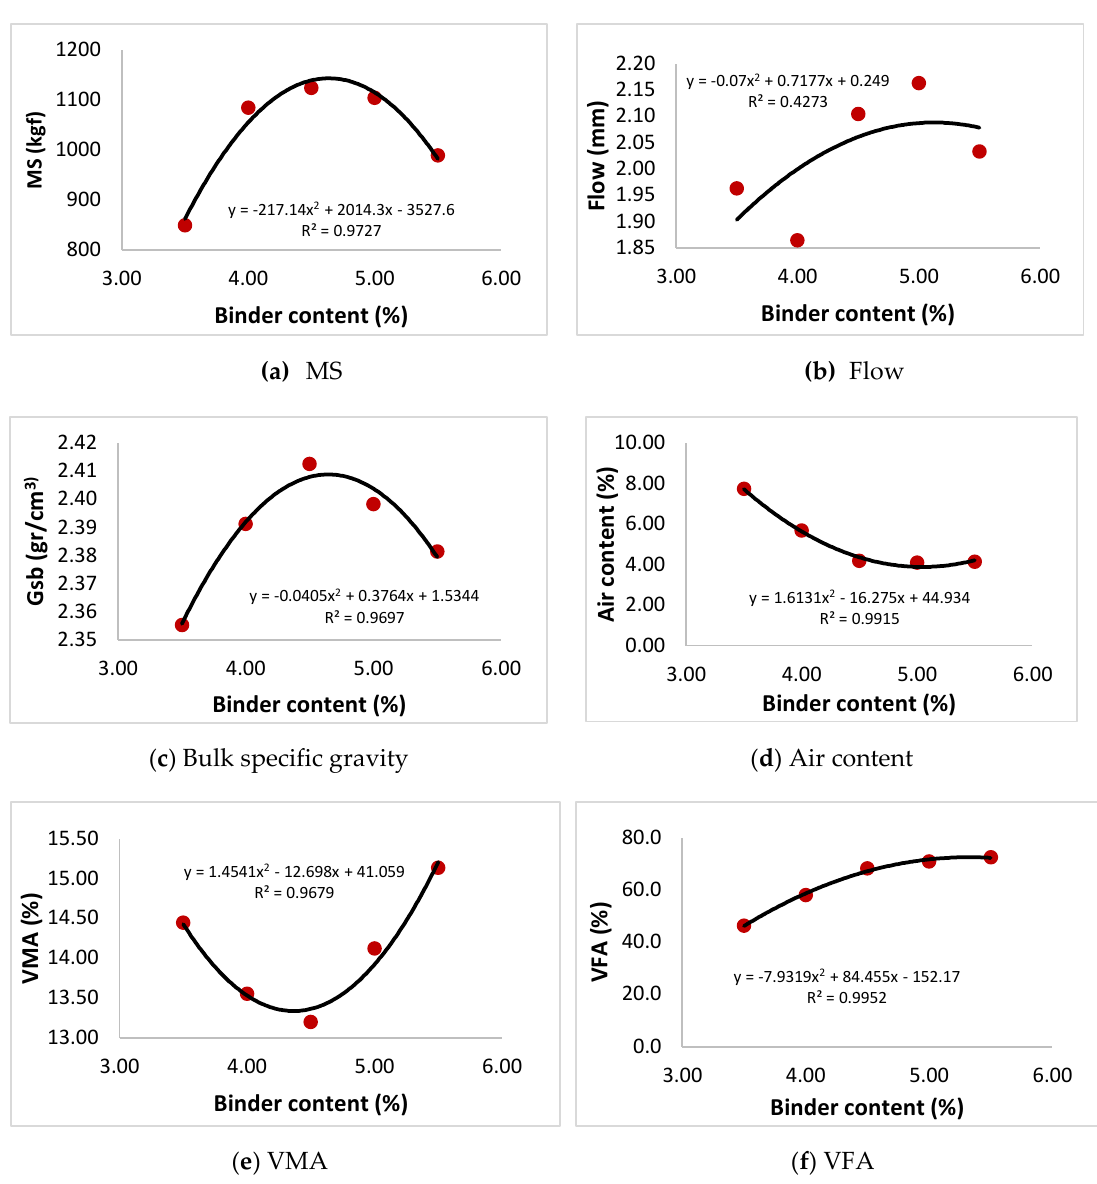
Figure 3. Test results for various binder content values.